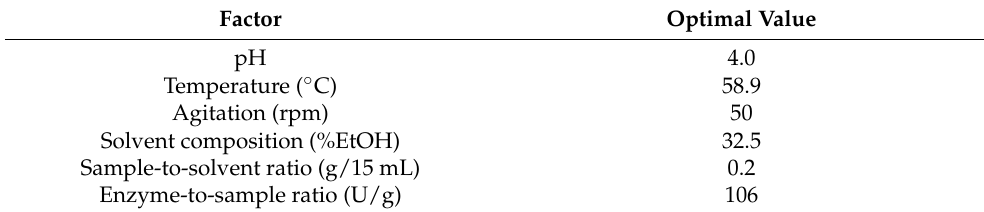
Figure 5. Plot representing the main effects of solvent composition, enzyme-to-sample ratio, pH and temperature. Table 5. Optimal values of the relevant variables in enzymatic